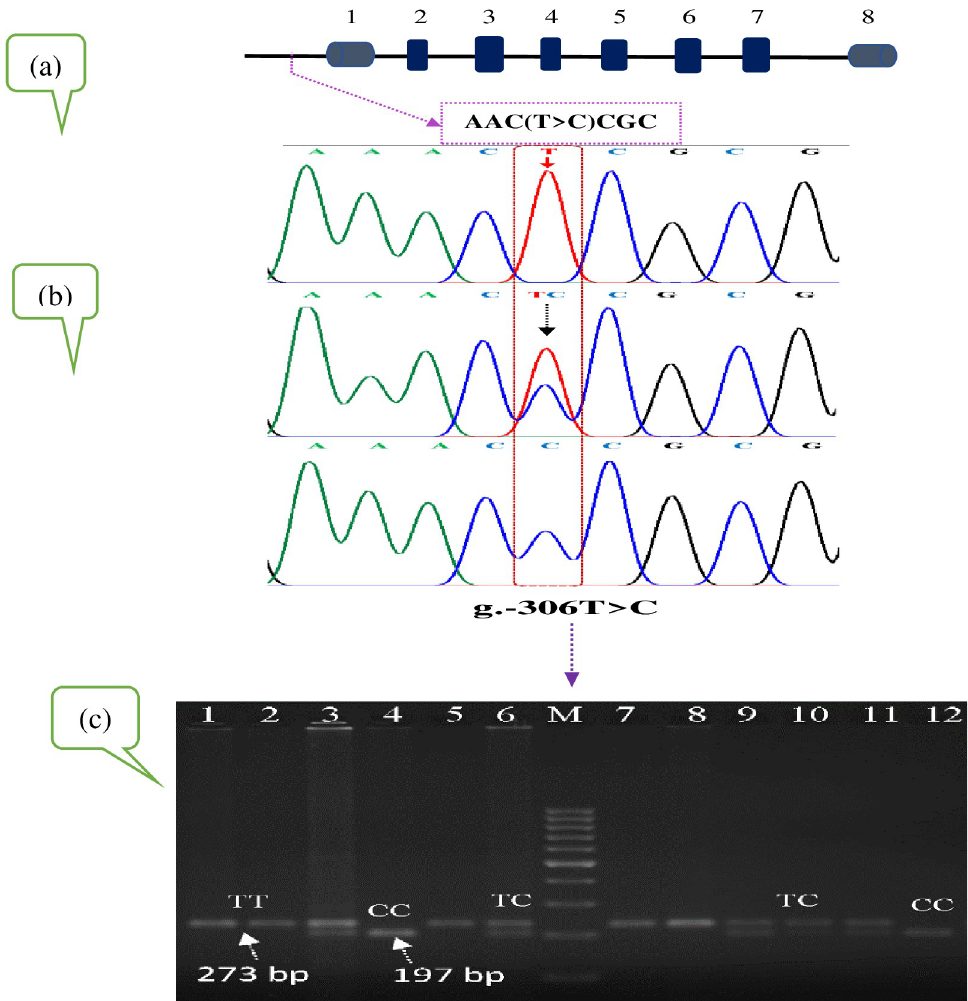
Fig 2. A schematic diagram of the present study to assess the SIRT1 gene polymorphism in the Sahiwal. (a) Schematic representation of the SIRT1 gene with the localization of the identified SNP. The line arrow, blue gray and dark blue boxes represent promoter and exons, respectively; intervals represent introns. (b) DNA sequencing chromatogram of the polymorphic fragment. (c) PCR-restriction fragment length polymorphism (PCR-RFLP) genotyping of the amplified